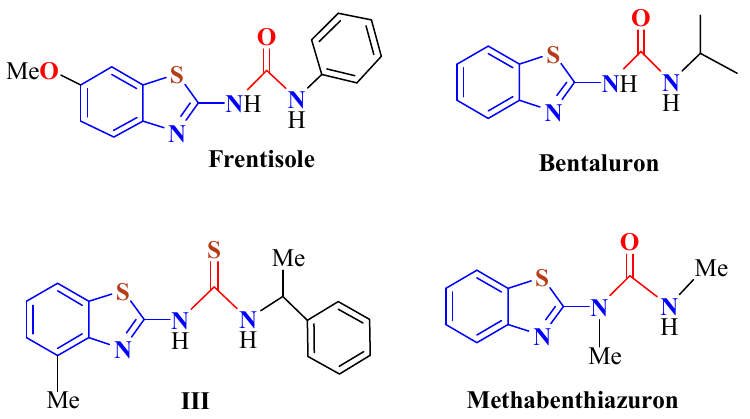
Figure 1. UBT and TBT derivatives with biological activities.